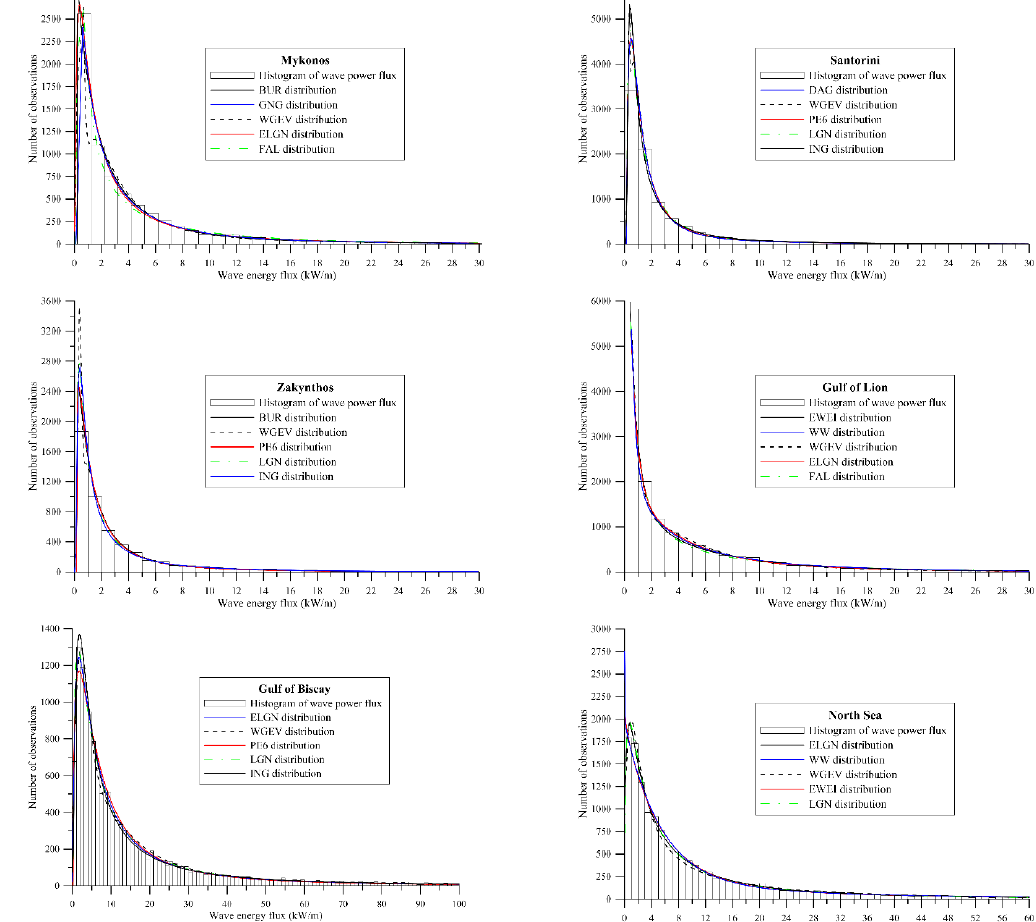
Figure 3. Histograms of wave energy flux along with the best fits from the corresponding probability density function at the examined locations.